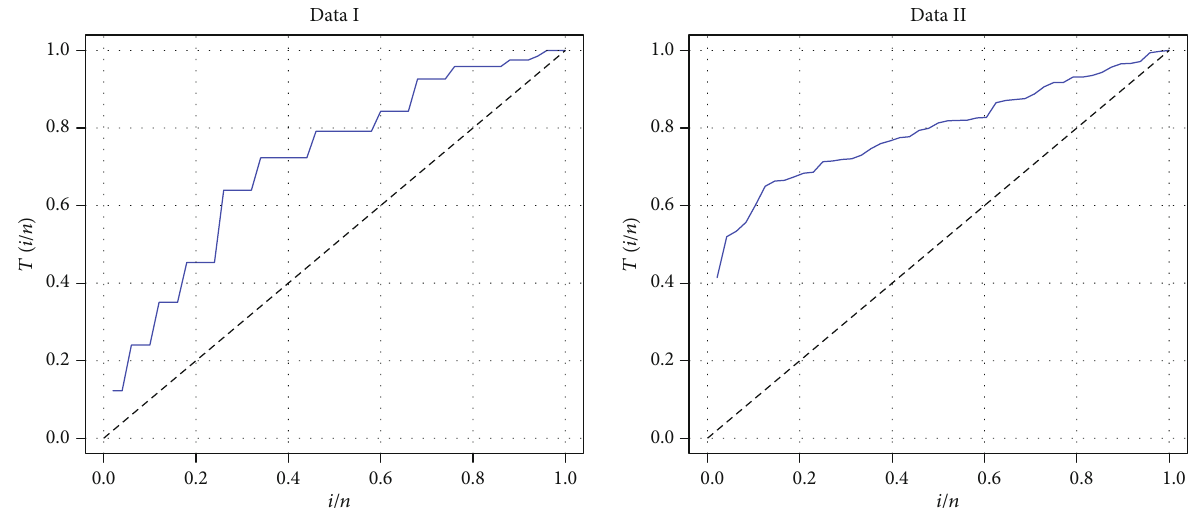
Figure 6: Total test time (TTT) for both data